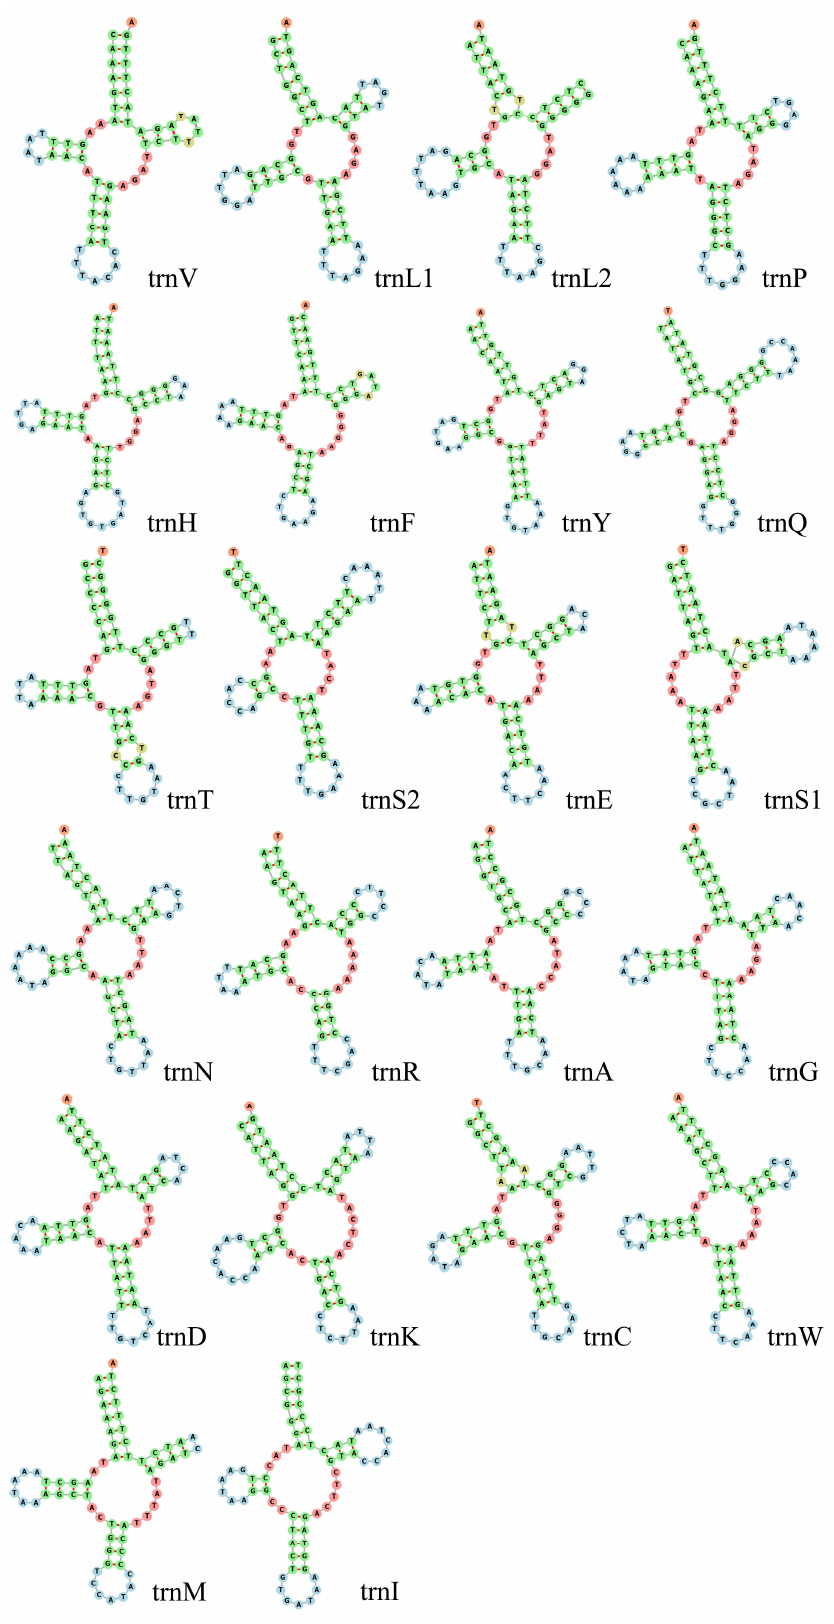
Figure 4. Secondary structure of 22 tRNA genes from the S. bungii mitochondrial genome.